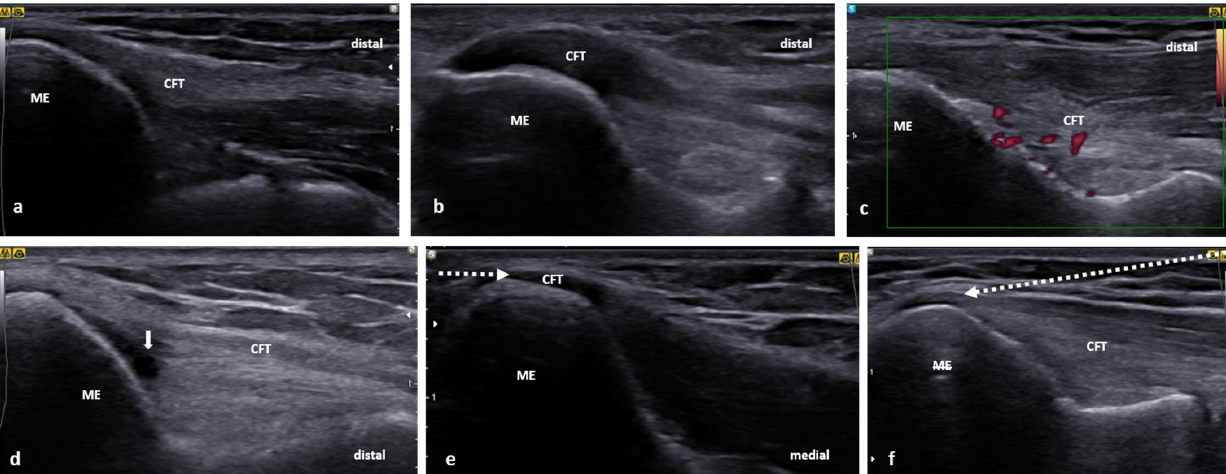
Figure 6. Ultrasound images of the CFT: ( a ) normal image of the CFT, ( b ) a severe thickening and hypoechogenicity of the CFT, ( c ) US image demonstrating degenerative changes and hypervascularity in the CFT, ( d ) small ganglion (white arrow) in the CFT, ( e ) US-guided peritendinous CET injection showing the needle (white, dotted arrow) being inserted from medial to lateral in a short axis of the CFT, ( f ) the needle (white, dotted arrow) can also be inserted from distal to proximal along the long axis of the CFT.